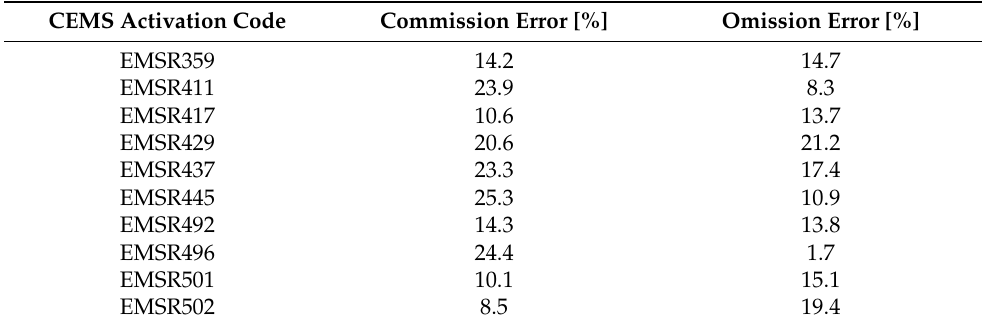
Table 7. Commission and omission errors for the class of open floodwater.